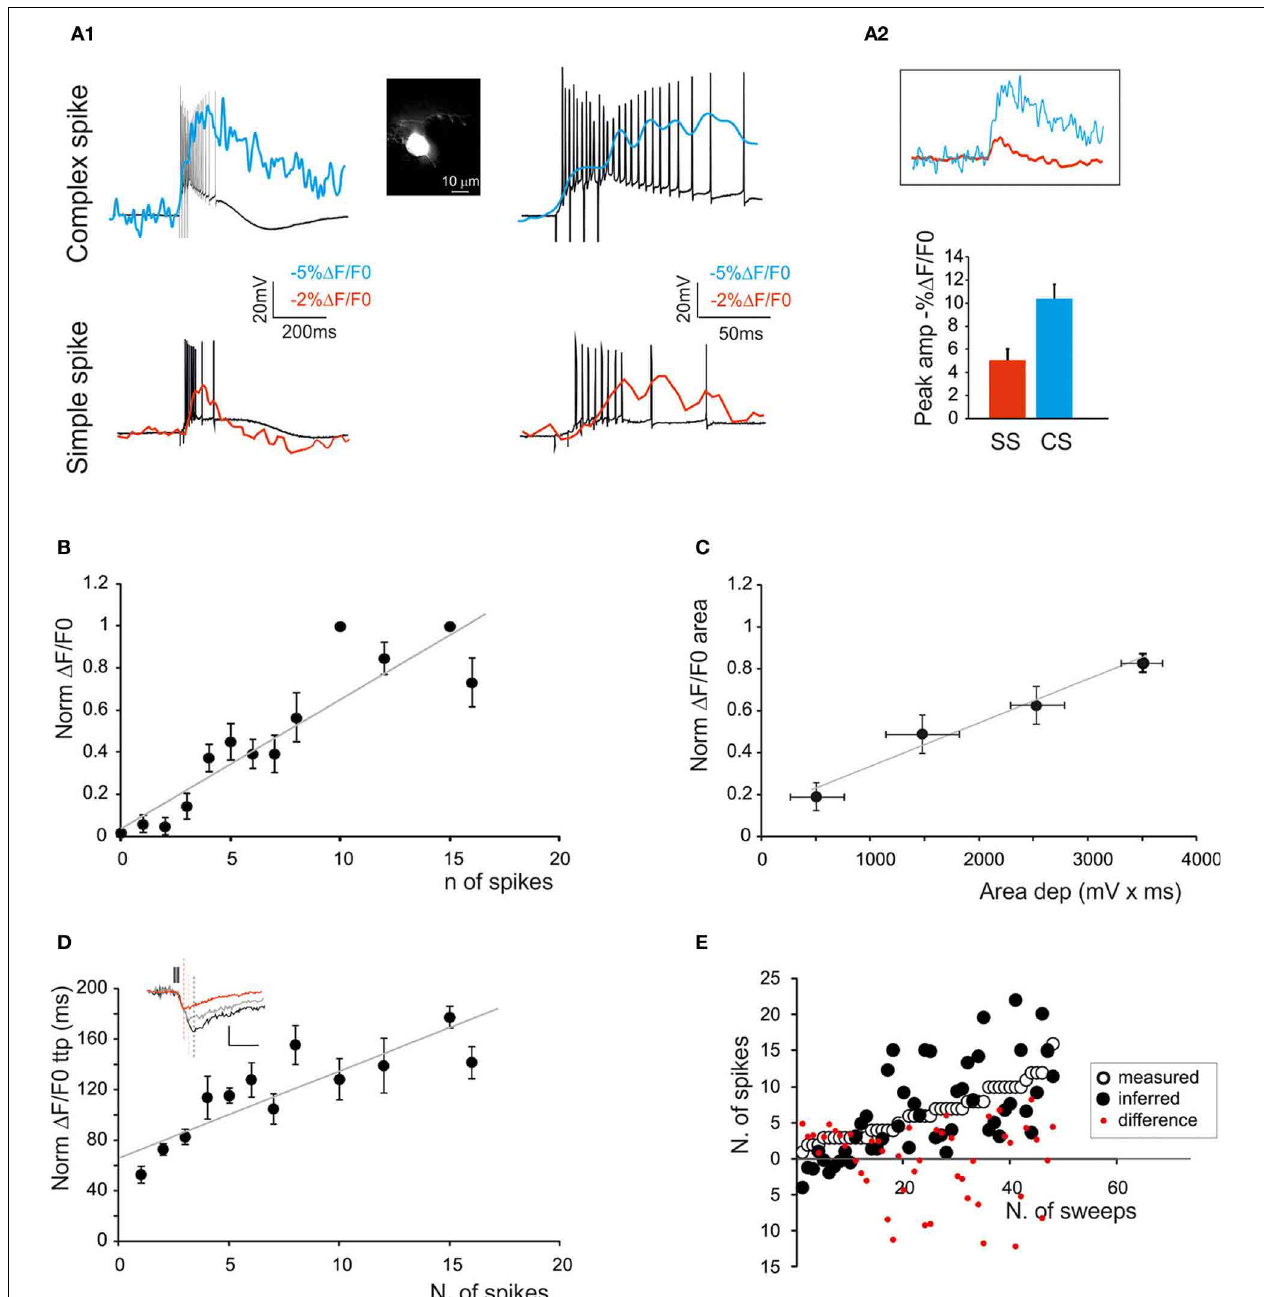
mean ± s.e.m.). (C) Dependence of normalized (cid:3) F/F 0 area on the average depolarization during simple spike discharge in response to mossy fiber bursts (5 stimuli at 100Hz) revealing a linear correlation (gray line; n = 4 cells R 2 = 0 . 63; p < 0 . 05; mean ± s.e.m.). Only sub-threshold responses were considered. (D) Dependence of normalized (cid:3) F/F 0 time-to-peak on the number of simple spikes emitted in response to mossy fiber bursts (5 stimuli at 100Hz) revealing a linear correlation (gray line; R 2 = 0 . 56; p < 0 . 01; mean ± s.e.m.). The traces in the inset show (cid:3) F/F 0 signals correlated with one (red), five (gray) and 10 spikes (black) (E) Comparison of the number of spikes actually measured in PCs and that predicted by the slope of the time-to-peak vs . spike relationship shown in (D) . Note the matching between predicted and measured results (two-tailed t -test; p = 0 .